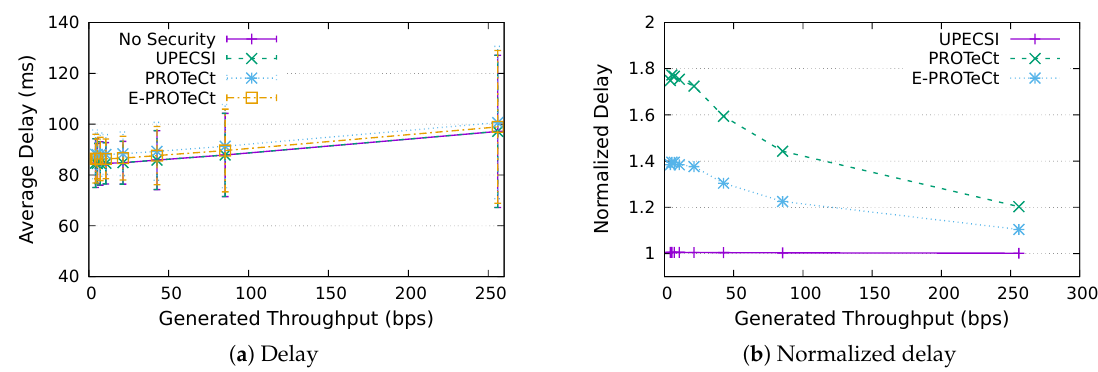
Figure 13. Delay analysis for an IoT network with 16 devices.